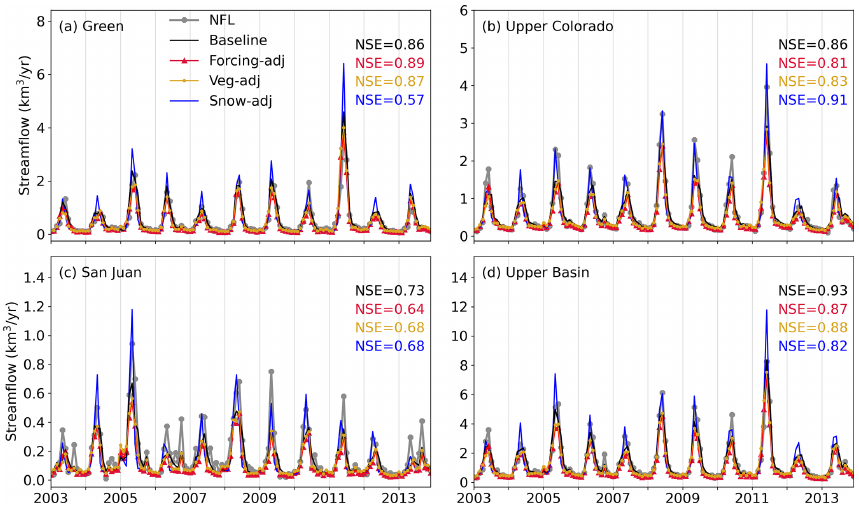
Figure 12. Monthly time series of naturalized streamflow (NFL) and streamflow from baseline, Forcing-adj, Veg-adj, and Snow-adj simula- tions at (a) Green, (b) Upper Colorado, (c) San Juan, and (d) Upper Basin for 2003–2013. NSE values are also